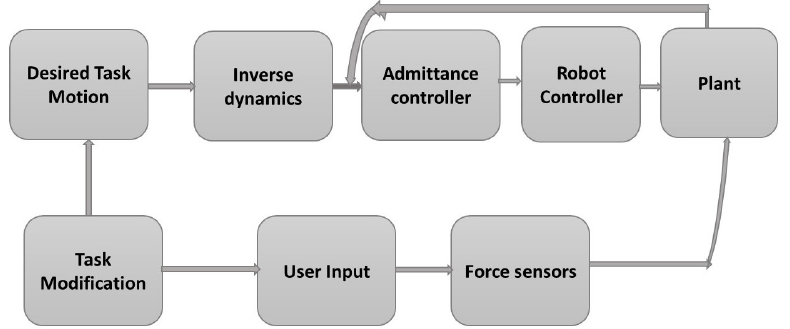
Figure 7. Simplified diagram for an admittance-based collaborative task